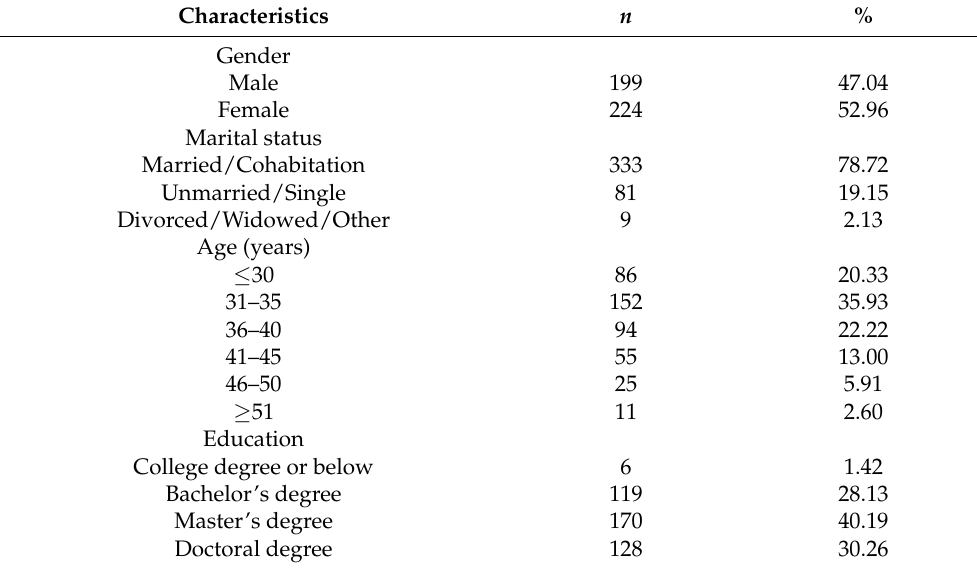
Table 1. Demographic characteristics of the respondents ( n =